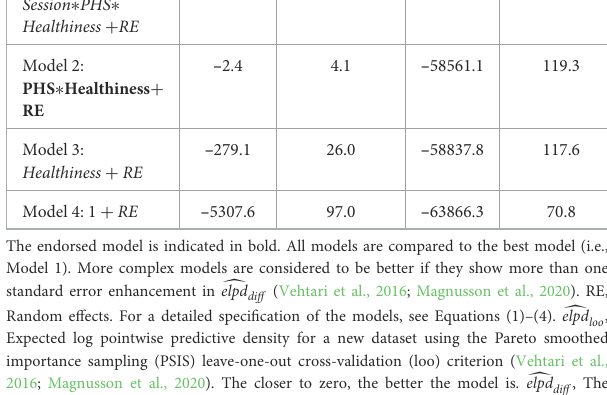
TABLE 1 Fit indices of the preference models computed by multilevel Bayesian cumulative modeling (ordered by fit). Preference